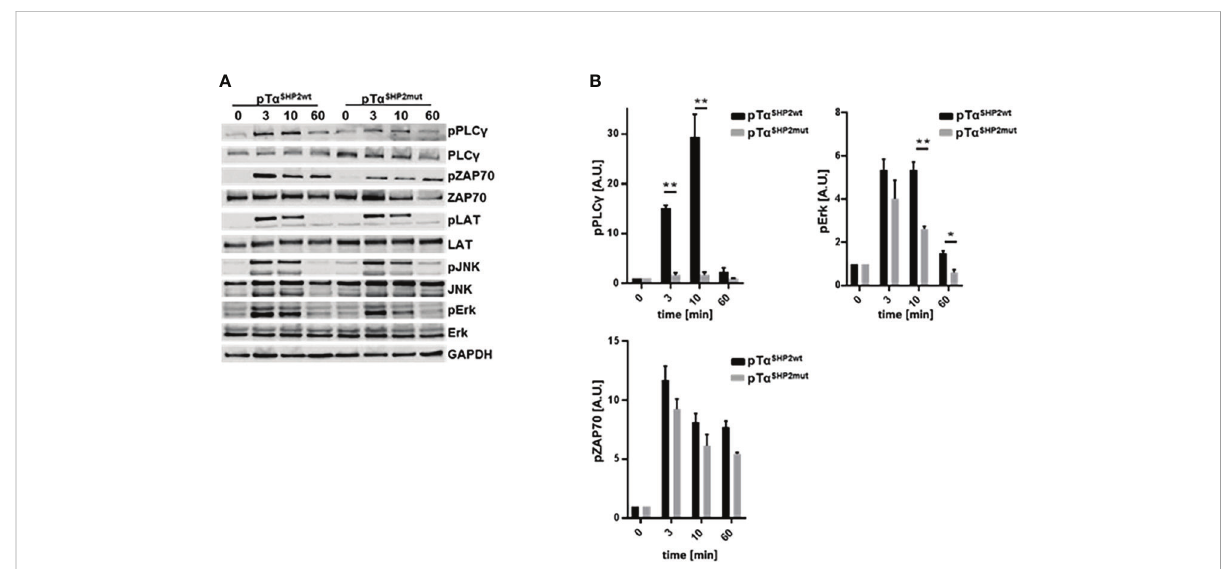
FIGURE 5 Reduced phosphorylation of PLC g and Erk upon TCR triggering in pT a SHP2mut mice. (A) Pan T cells were puri fi ed from splenocytes and components of the TCR signaling cascade were analyzed after 0, 3, 10 and 60 minutes following soluble a -CD3 (5µg/ml) stimulation via immunoblot, n=3. One representative experiment out of three is shown. (B) Densitometric analysis of the phosphorylation of PLC g , ZAP70 and Erk, band intensities were normalized to the corresponding non-phosphorylated protein and the loading control GAPDH. (*p<0.05, **p<0.01, Student ’ s t-test, mean + SD).